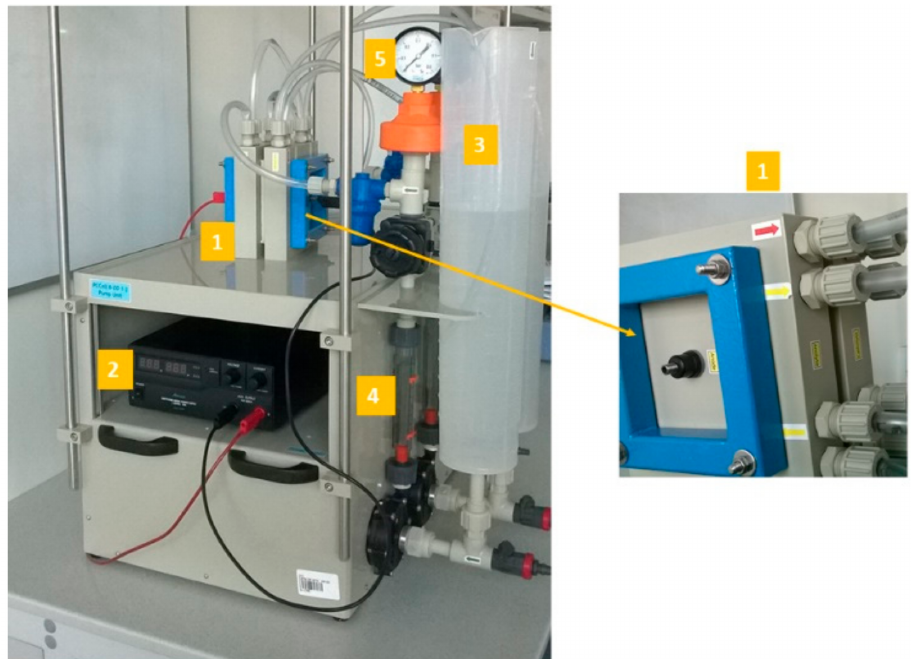
Figure 1. Photo of the installation for the electrodialysis process: 1—ED cell; 2—power supply; 3—solution tanks; 4—rotameters; 5—manometer.